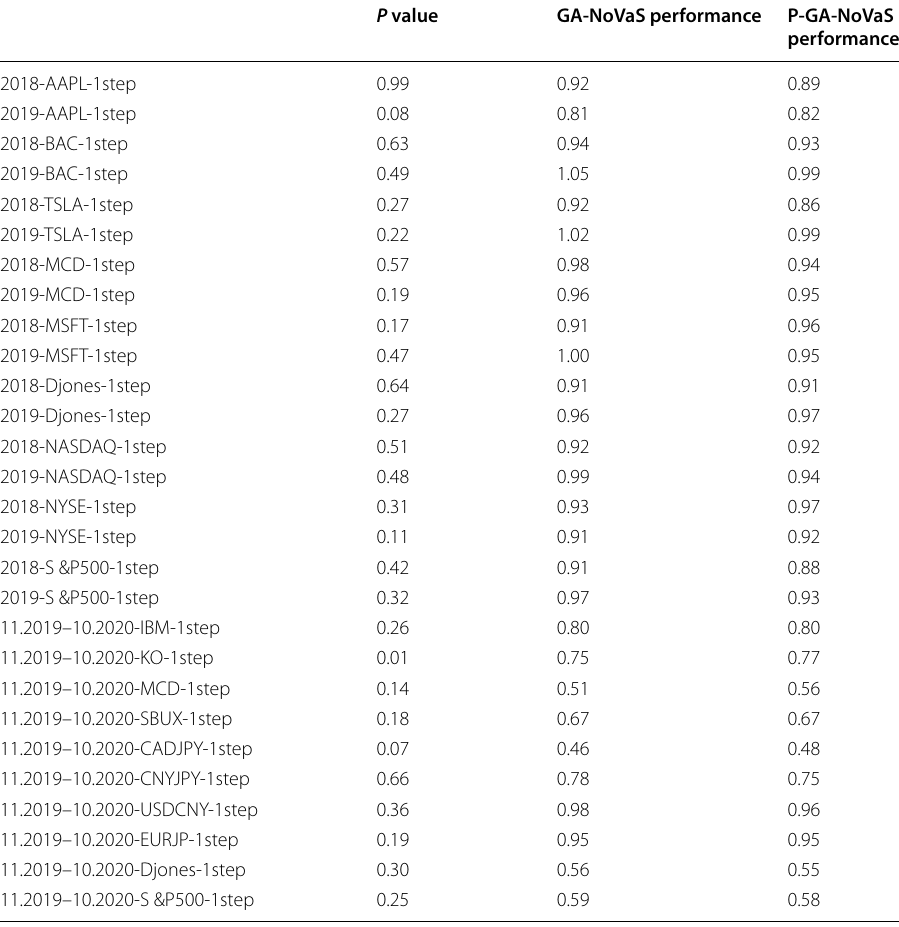
Table 8 CW-tests on 1-step ahead predictions of GA-NoVaS and P-GA-NoVaS